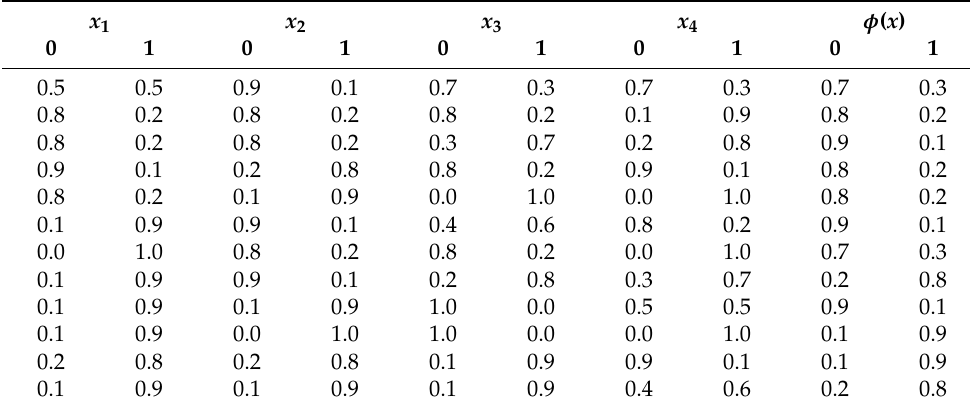
Table 3. Uncertain data of a laparoscopic surgery